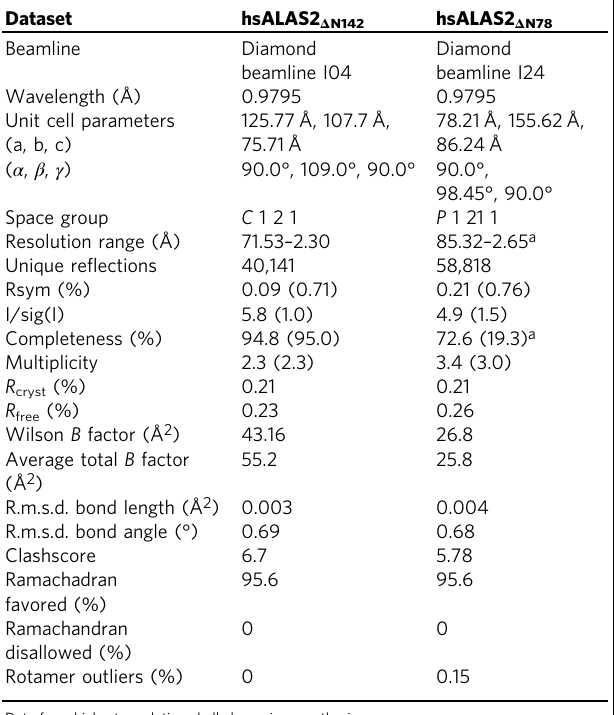
Table 1 Data collection and re fi nement statistics for hsALAS2 Δ N142 and hsALAS2 Δ N78 crystal